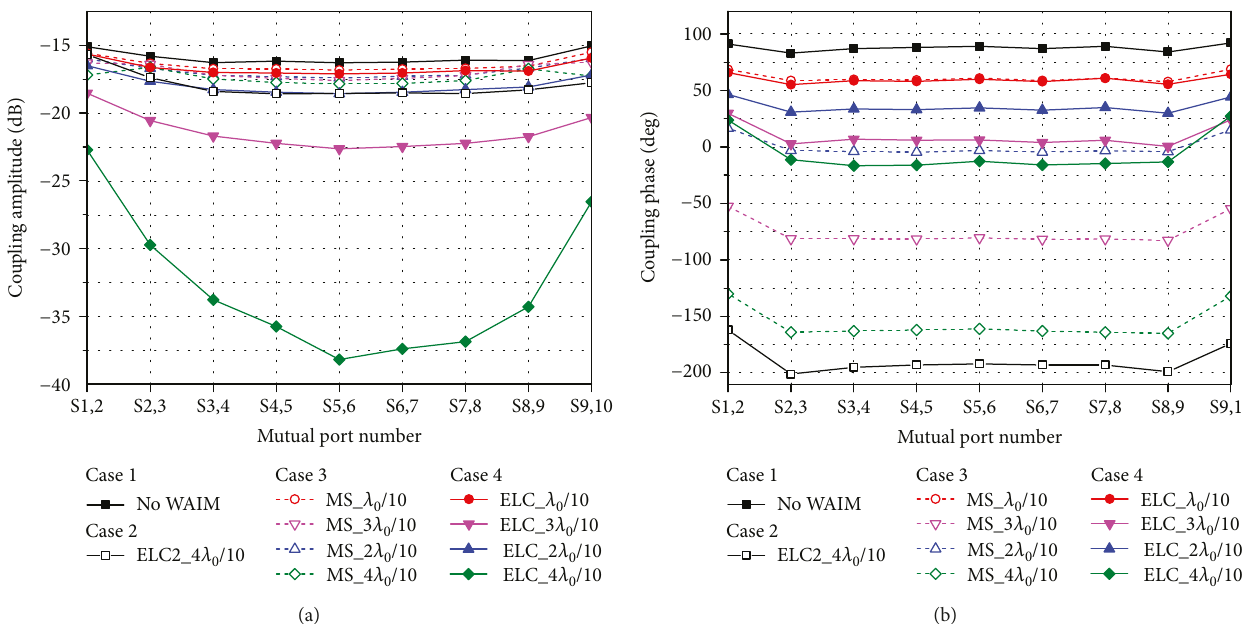
Figure 5: Mutual couplings between two adjacent SIWs at 10.0GHz in the four cases. (a) Amplitude and (b) phase. The value following the underline in the graph legends presents the height of the 4 λ /10 height and the ELC2 metasurface slab of 4 λ 0 decrease the amplitude within 2 dB with respect to case 1.